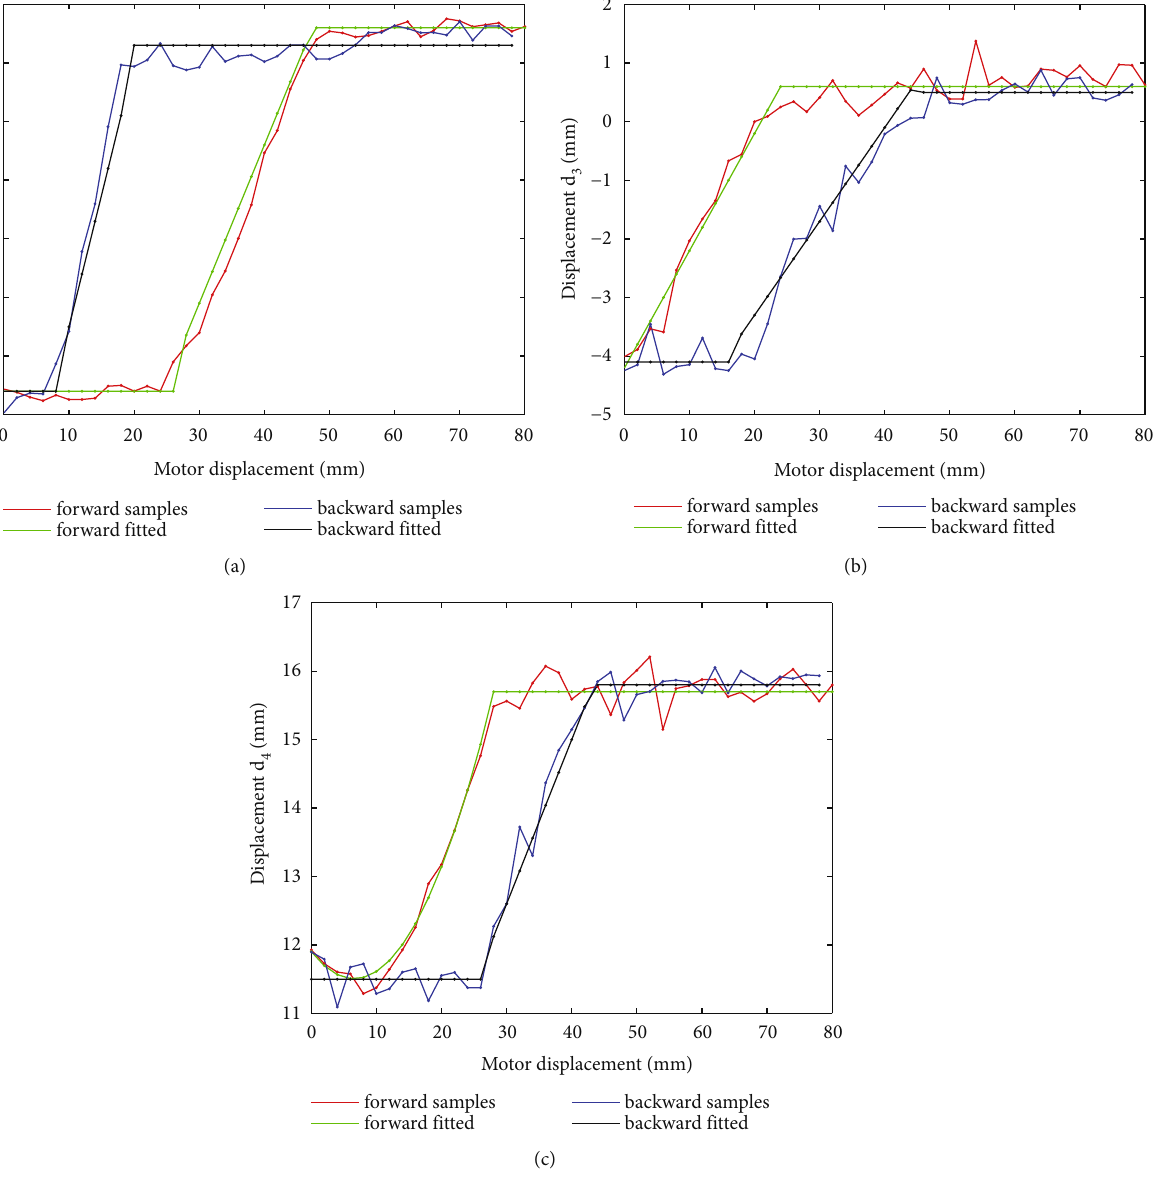
Figure 9: Displacements measured in both forward and backward